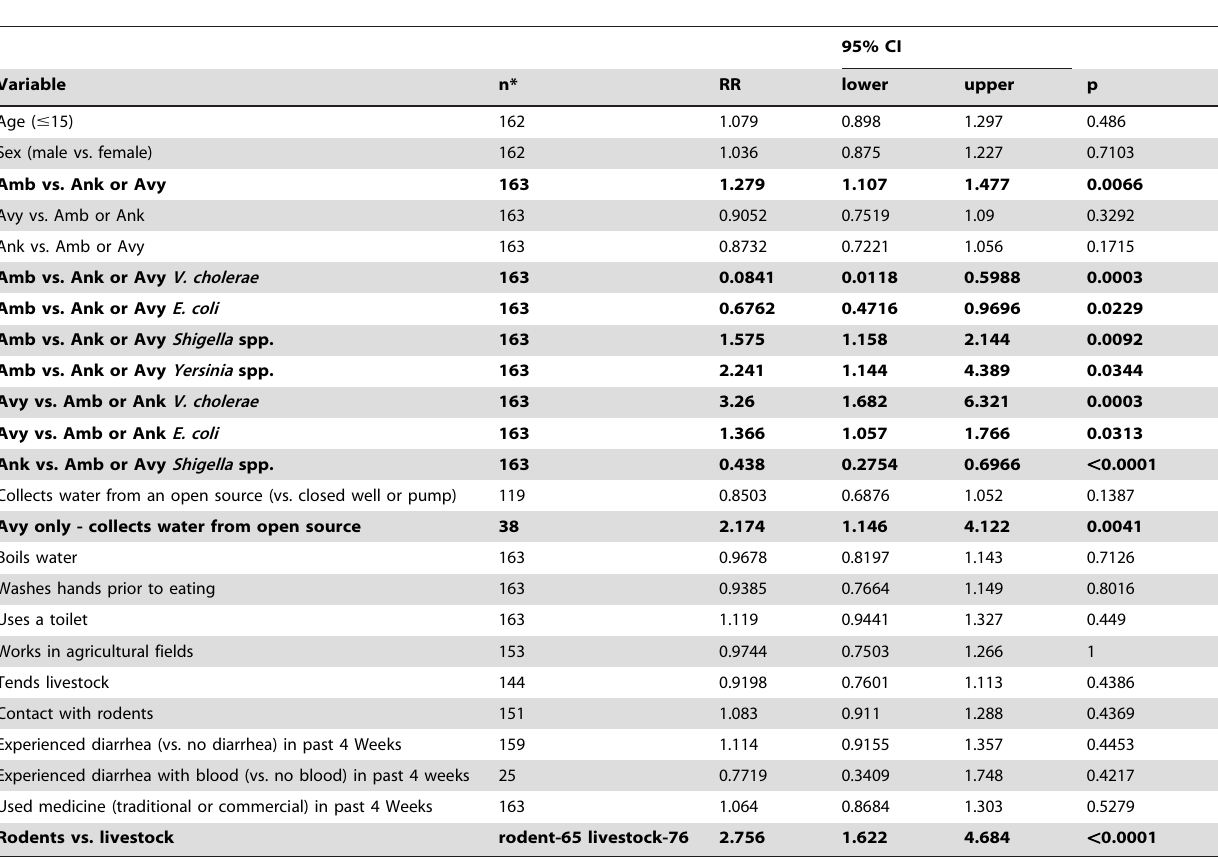
Table 4. Risk factors for infection with Enterobacteriaceae in people living in villages in Southeast